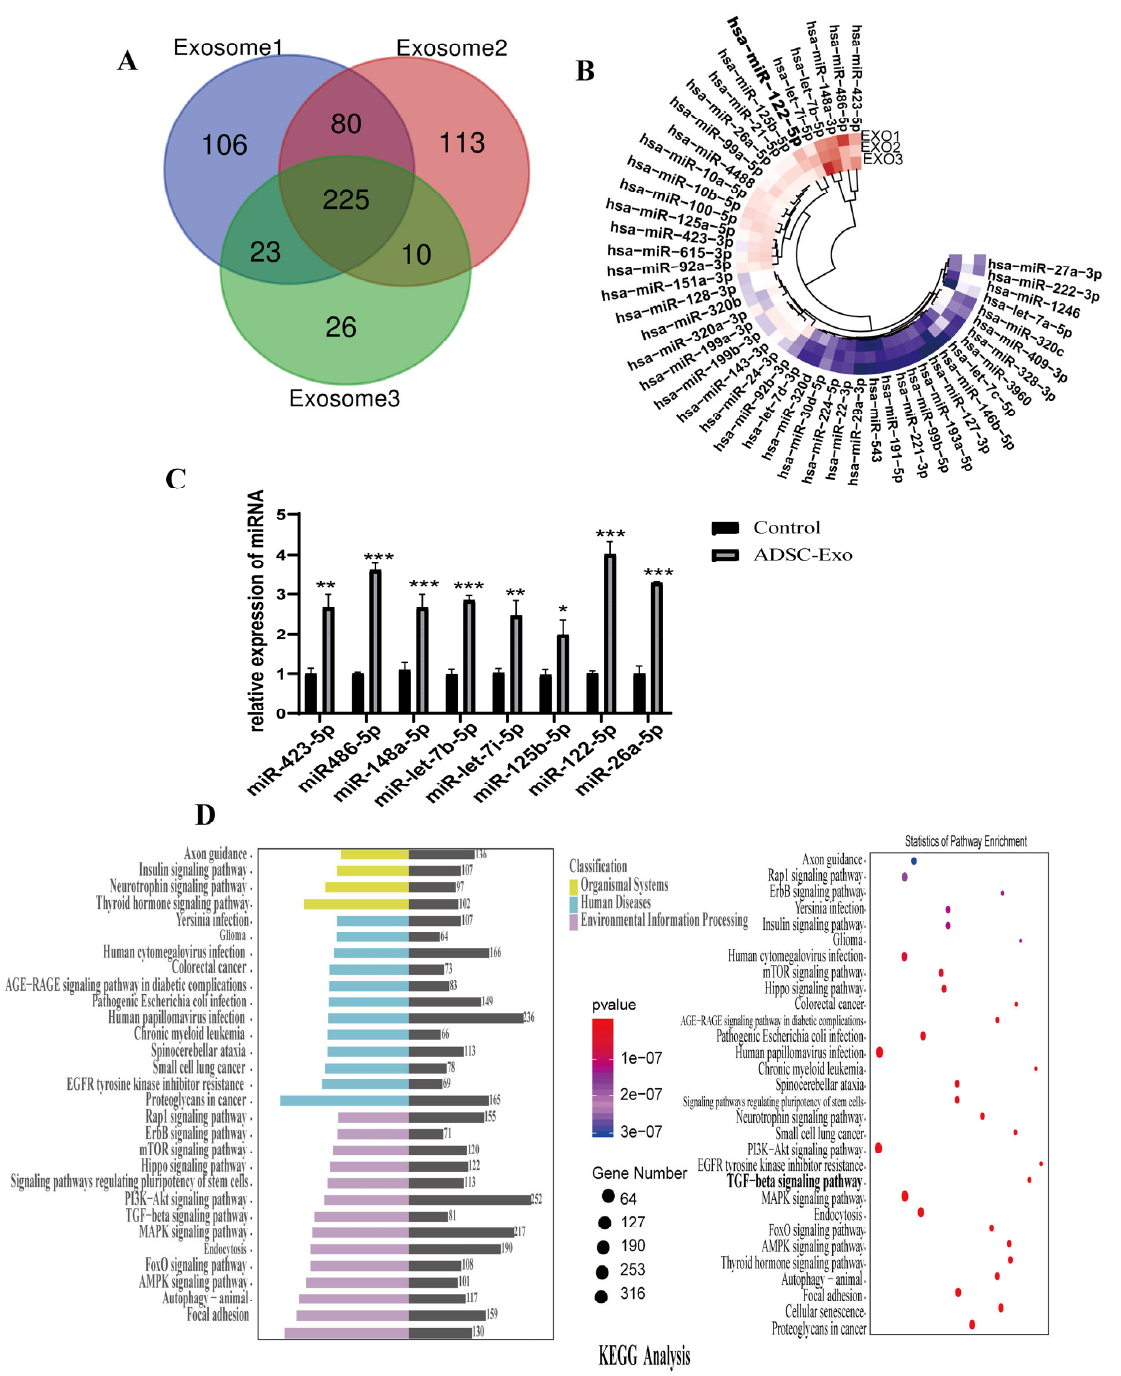
Figure 3. Identification and screening of differentially expressed miRNAs in ADSC-Exos. ( A ) Three exosome samples were performed from three patients with the same baseline and extracted by gradient ultracentrifugation. A total of 225 miRNAs were identified by miRNA sequencing. ( B ) Heatmap and clustering analysis of the top 50 miRNAs contained in the ADSC-Exos. MiRNA expression levels are indicated by colors: red represents high values, and blue represents low. ( C ) qRT-PCR was performed to verify the expression of the top eight miRNAs in DPCs and DPCs-treated with ADSC-Exos. The data represent the means ± SD. DPCs treated with PBS were used as control group. * p < 0.05, ** p < 0.01, *** p < 0.001. ( D ) KEGG analysis shows the predicted target pathways of genes enriched in ADSC-Exos and the statistics of pathway